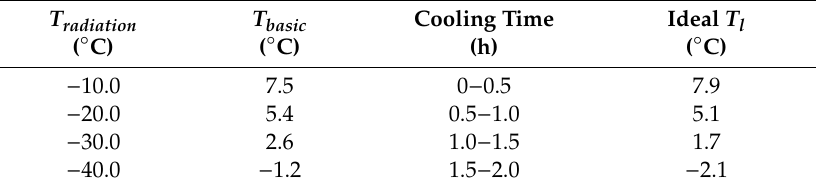
Figure 11. Comparison between the T l of actual ( ○ ) and ideal ( ■ ). Table 3. T l adjustment scheme.